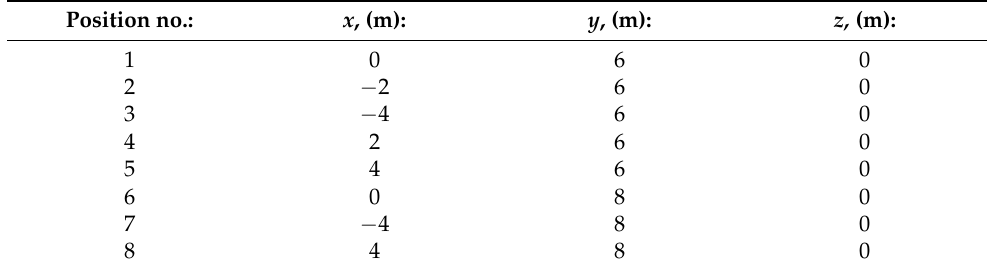
Figure 9. Positioning of the ultrasonic transducers during assessment of least on-axis distance be- tween transducers.